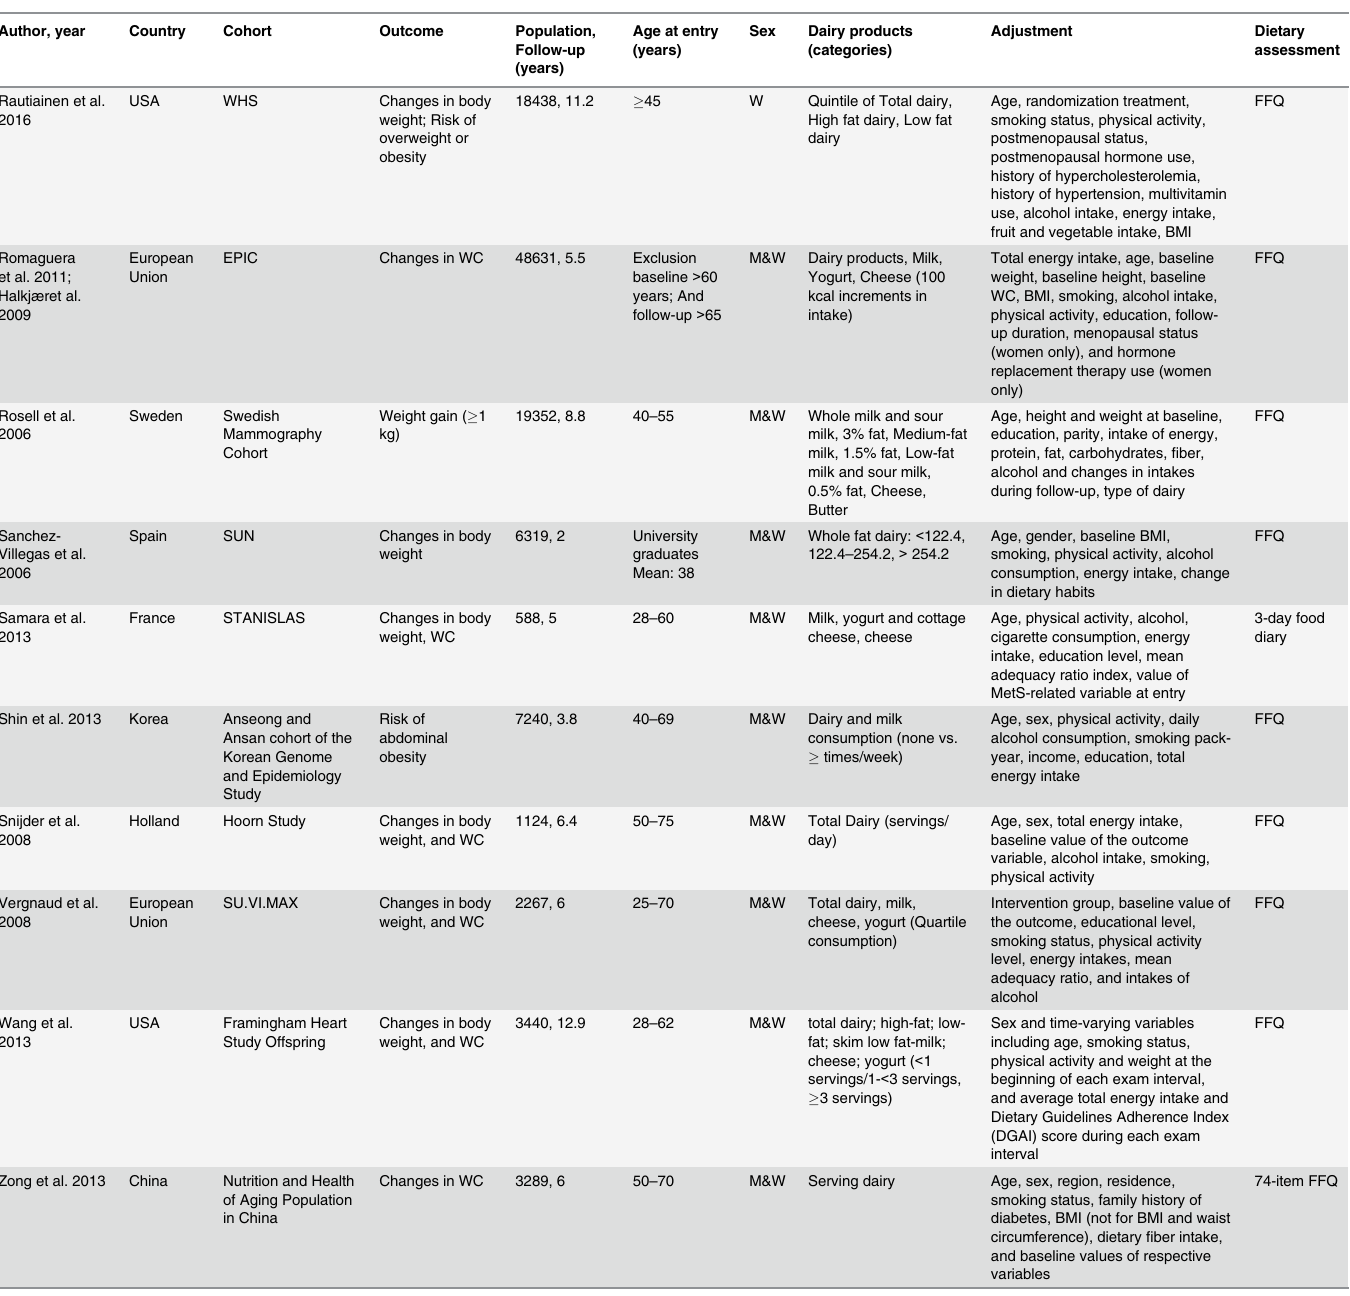
varied between 76 and 120,077 participants with a follow-up time ranging from 9 months to 23 years. All studies except for three (Iran, Korea, China) [24, 39, 43] were conducted in North America and Europe. The dairy (grams/servings/units, percentage of energy intake, frequency of consumption, or tertiles/quartiles/quintiles) categories and estimates (beta-coefficients,